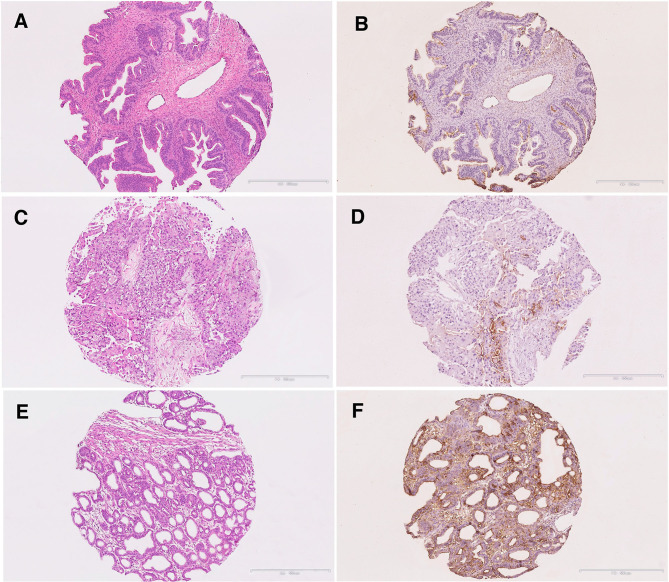
Immunohistochemical staining of S-Lc4 in Type 1 ovarian carcinoma. (A,B) Hematoxylin-eosin and S-Lc4 immunohistochemical staining in Mucinous carcinoma. (C,D) Hematoxylin-eosin and S-Lc4 immunohistochemical staining in Clear cell carcinoma. (E,F) Hematoxylin-eosin and S-Lc4 immunohistochemical staining in Endometrioid carcinoma. Scale bar represent 500 μm.